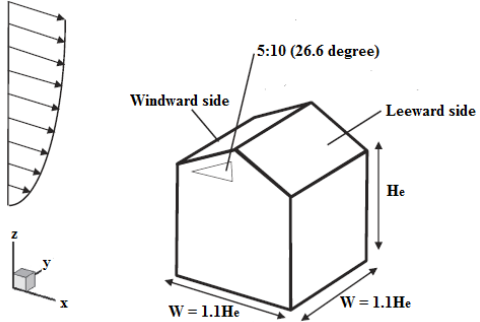
Figure 5. A Schematic diagram of the validation model [9].